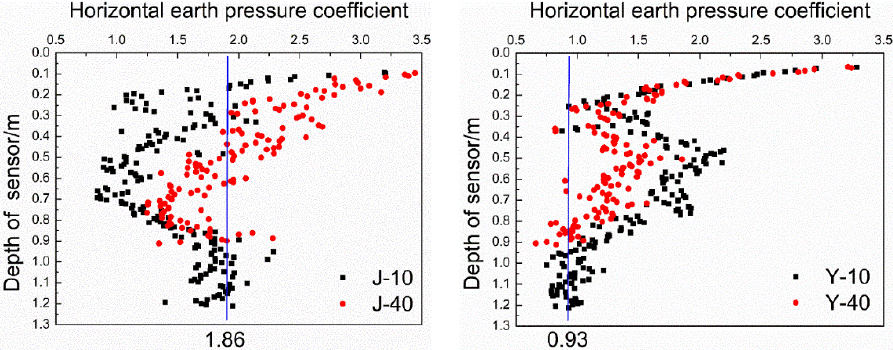
Figure 11. BB25 model. Note: J-10 and J-40 denote the soil-pressure sensor with different heights of 0.8 m from the side wall, and Y-10 and Y-40 denote the sensor on the other side of the model.